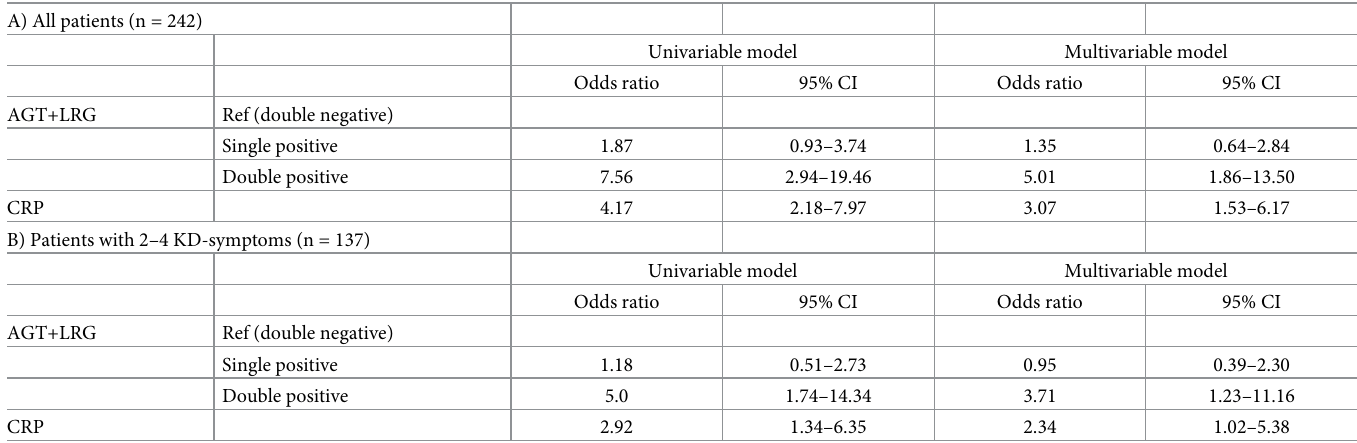
Table 3. Diagnostic values of AGT, LRG1, and CRP for